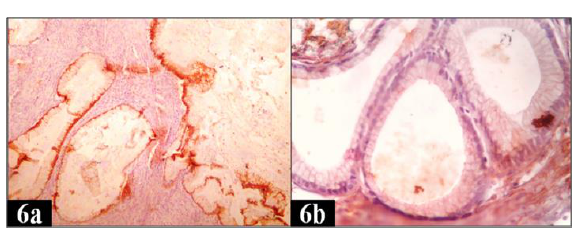
Fig 6. IHC expression of CK AE1/AE3 and vimentin in borderline mucinous tumor of ovary (a) Strong membranous staining of CK (100X) (b) Mild cytoplasmic expression of vimentin (400X)